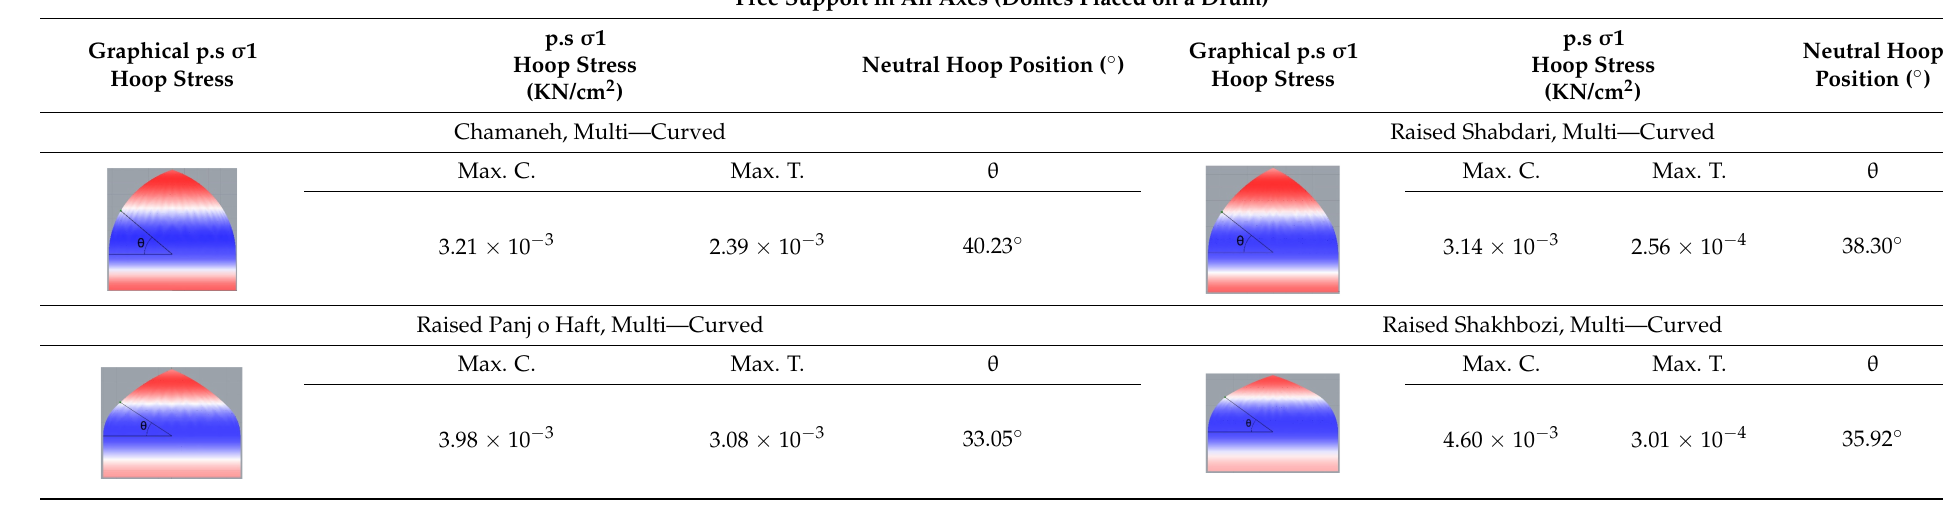
Free Support in All Axes (Domes Placed on a Drum)